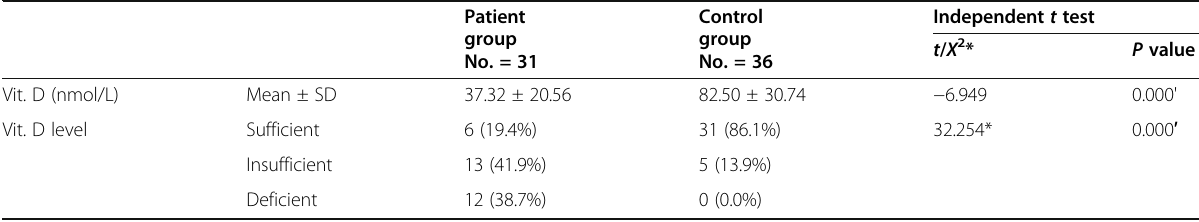
Table 4 Serum vitamin D level and comparison to normal